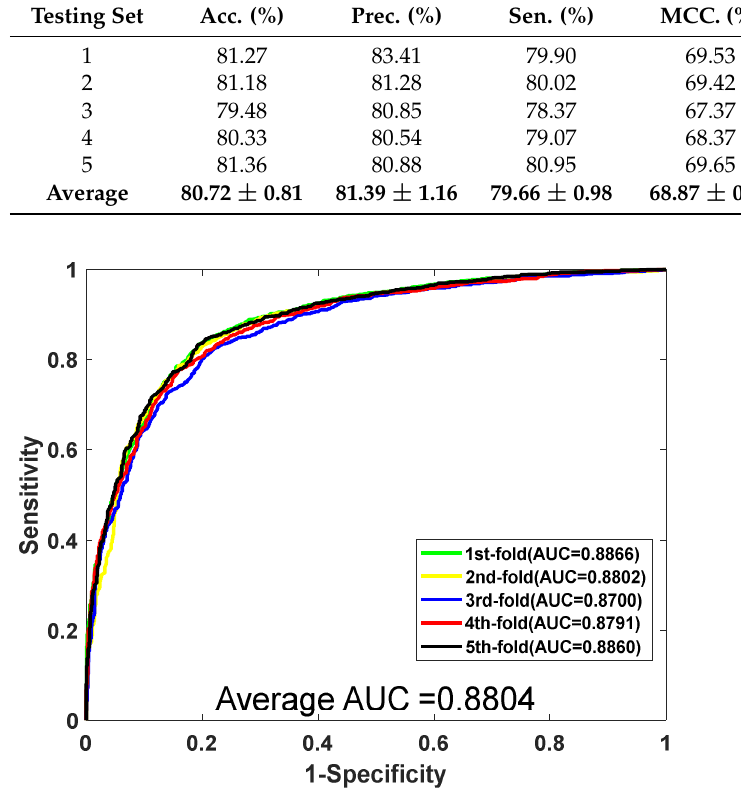
Figure 4. The ROC curve of the SVM classifier on the Yeast dataset. Table 5. Prediction performance of H. pylori dataset based on five-fold cross-validation